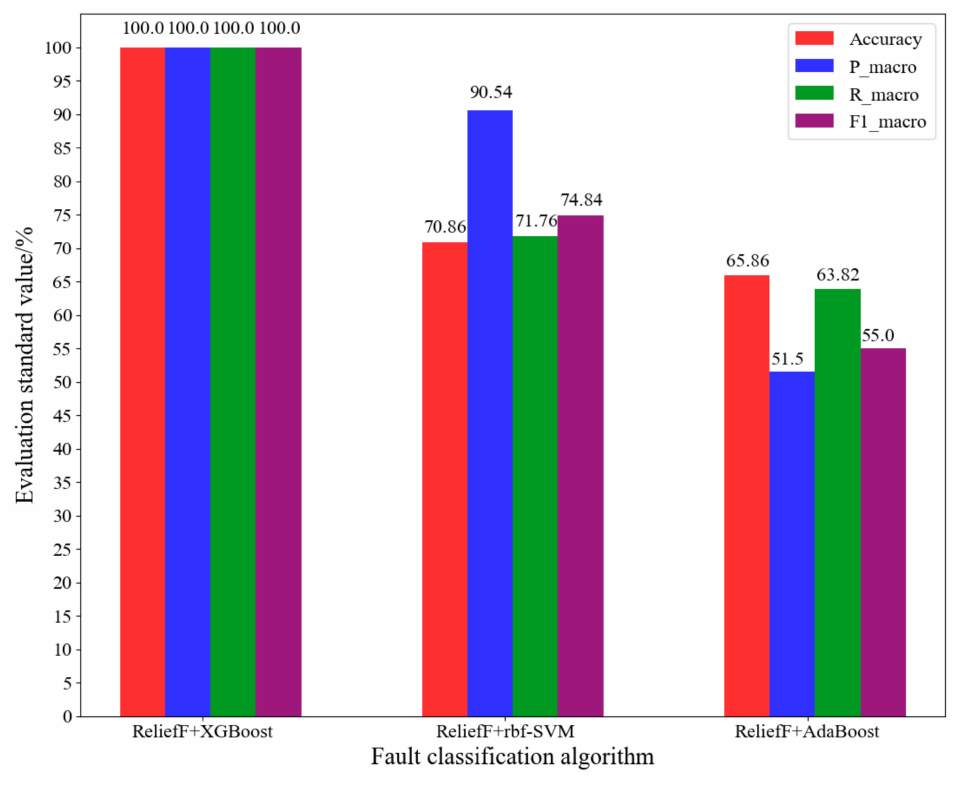
Figure 5. The result of the fault classification